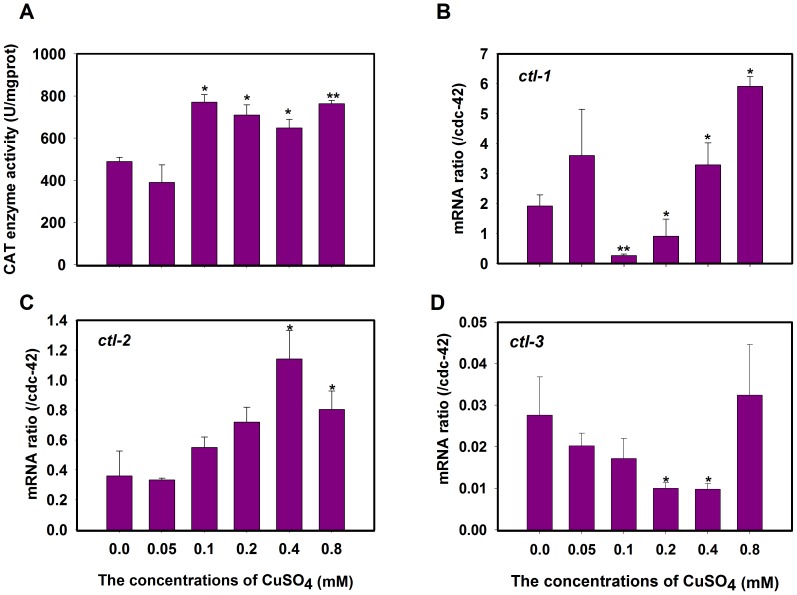
CATs activities or mRNA expression induced by copper in C. elegans.(A) The CAT activity and H2O2 content were changed during the copper stress. Values are presented as the means ±SE (n = 3) in U g−1 Pr. and mmol mg−1 Pr. The gene expressions of ctl-1(B), ctl-2 (C), and ctl-3 (C) were quantified in nematode N2 under the stress of different concentration of copper and normalized with cdc-42. *P<0.05, **P<0.01 versus respective controls analyzed by t-test.